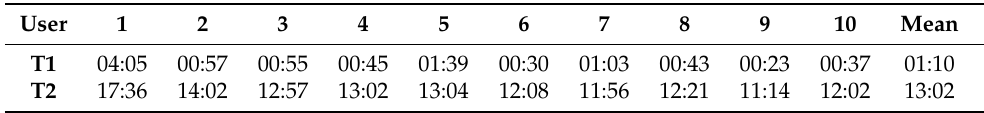
Table 4. Completion times, in minutes, for the two tasks (T1 and T2,